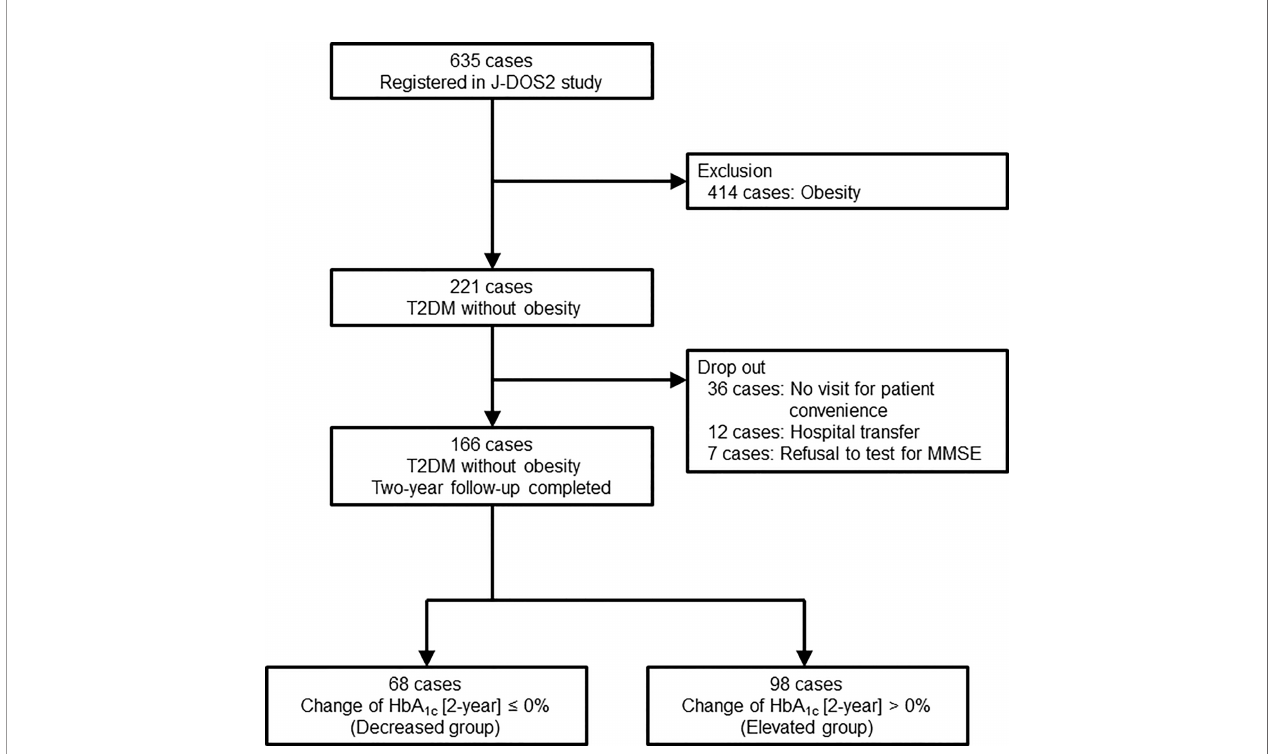
FIGURE 1 | Flow chart of the study. J-DOS2, Japan Diabetes and Obesity Study2; T2DM, type 2 diabetes mellitus; MMSE, mini-mental state examination; HbA 1c , hemoglobin A 1c